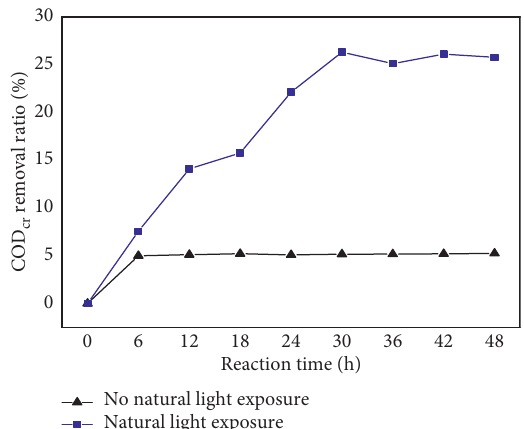
Figure 2: Effect of sunlight illumination time on COD